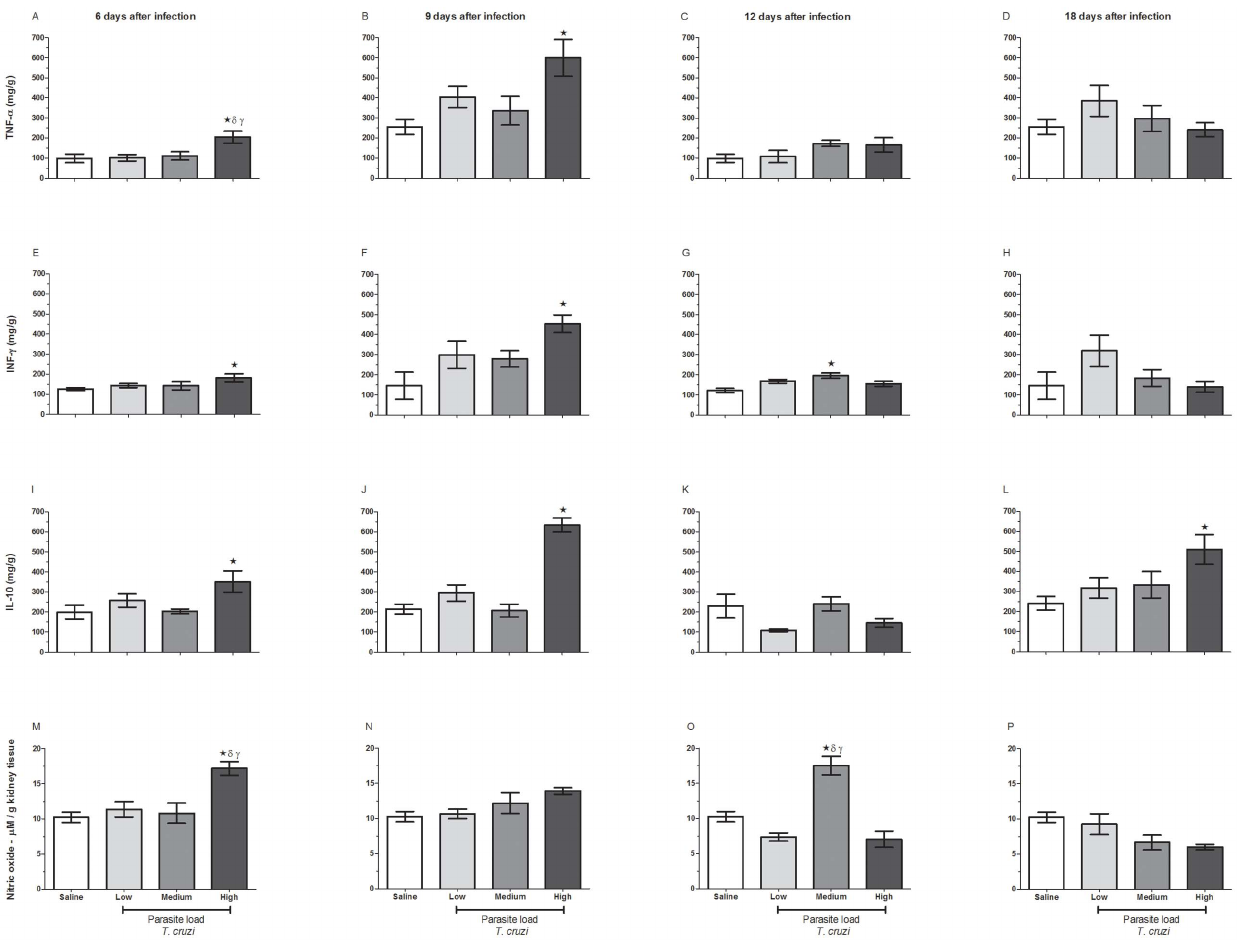
Figure 6. Effect of T.cruzi parasite loads on cytokine and nitric oxide production in kidney tissues. C57BL/6 mice were challenged with low, medium and high loads of blood trypomastigotes. At 6, 9, 12 and 18 days post-infection they were euthanized and their kidneys were removed to measure the concentrations of cytokines and nitric oxide. The cytokines TNF- a (A–D), IFN- c (E–H) and IL-10 (I–L) were measured according to the manufacturer’s instructions, using commercially available ELISA kits. For measurement of nitric oxide, the Griess reaction was used. The absorbance was read at 570 nm. *p # 0.05 indicates a significant difference when animals from the medium and highly infected groups were compared to the uninfected control